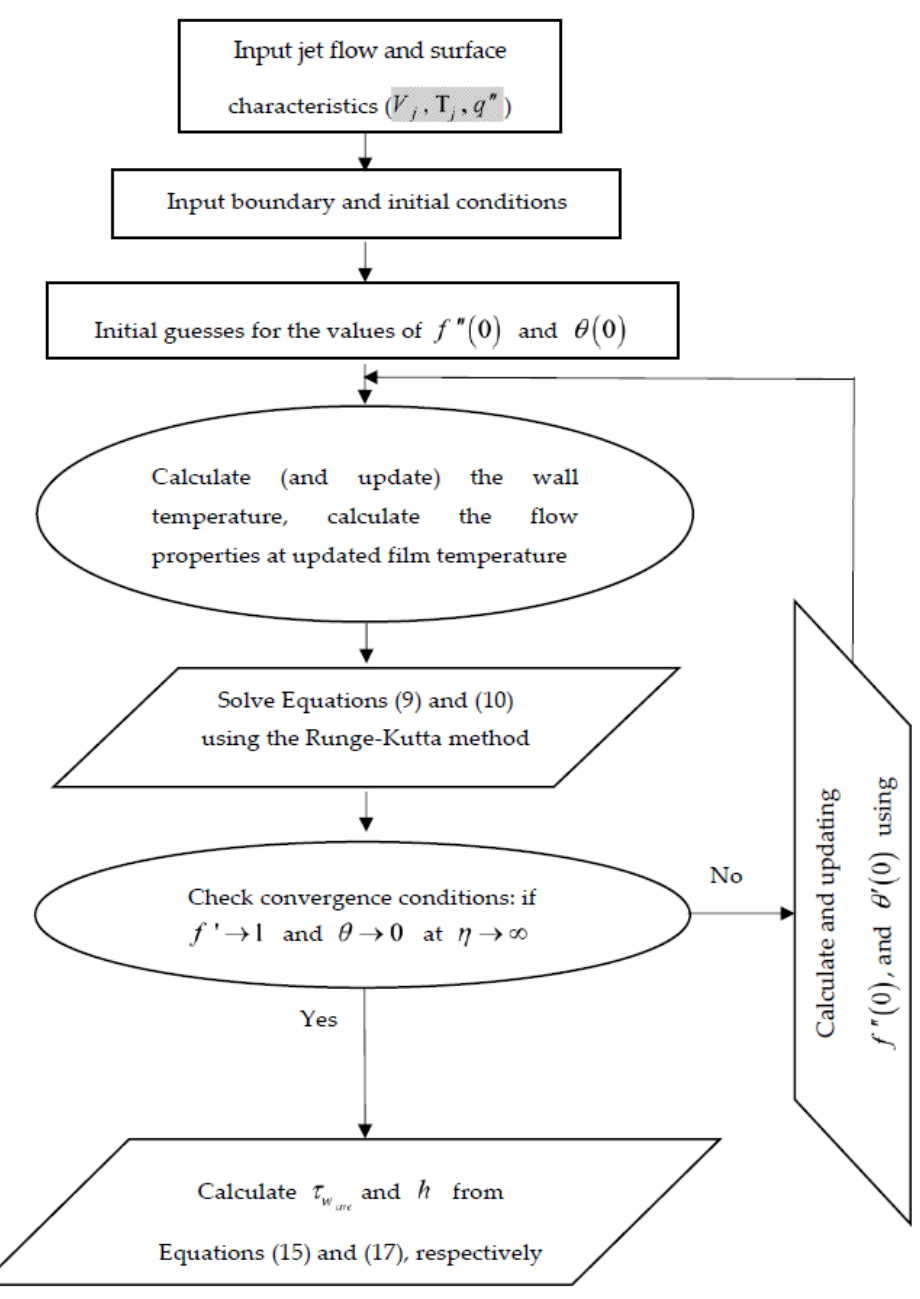
Figure 2. The flowchart for the numerical procedure.